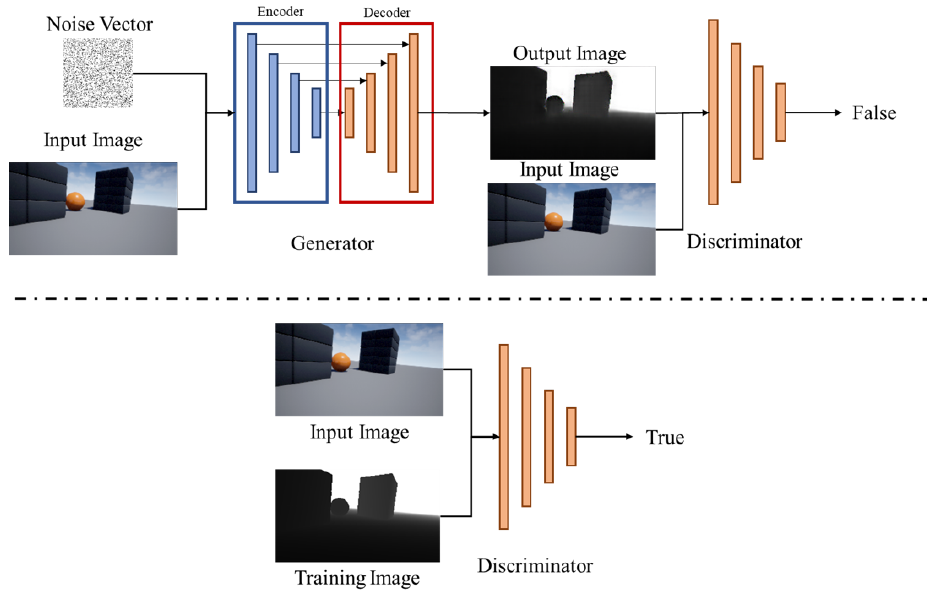
Figure 4. CGAN Network of Pix2Pix